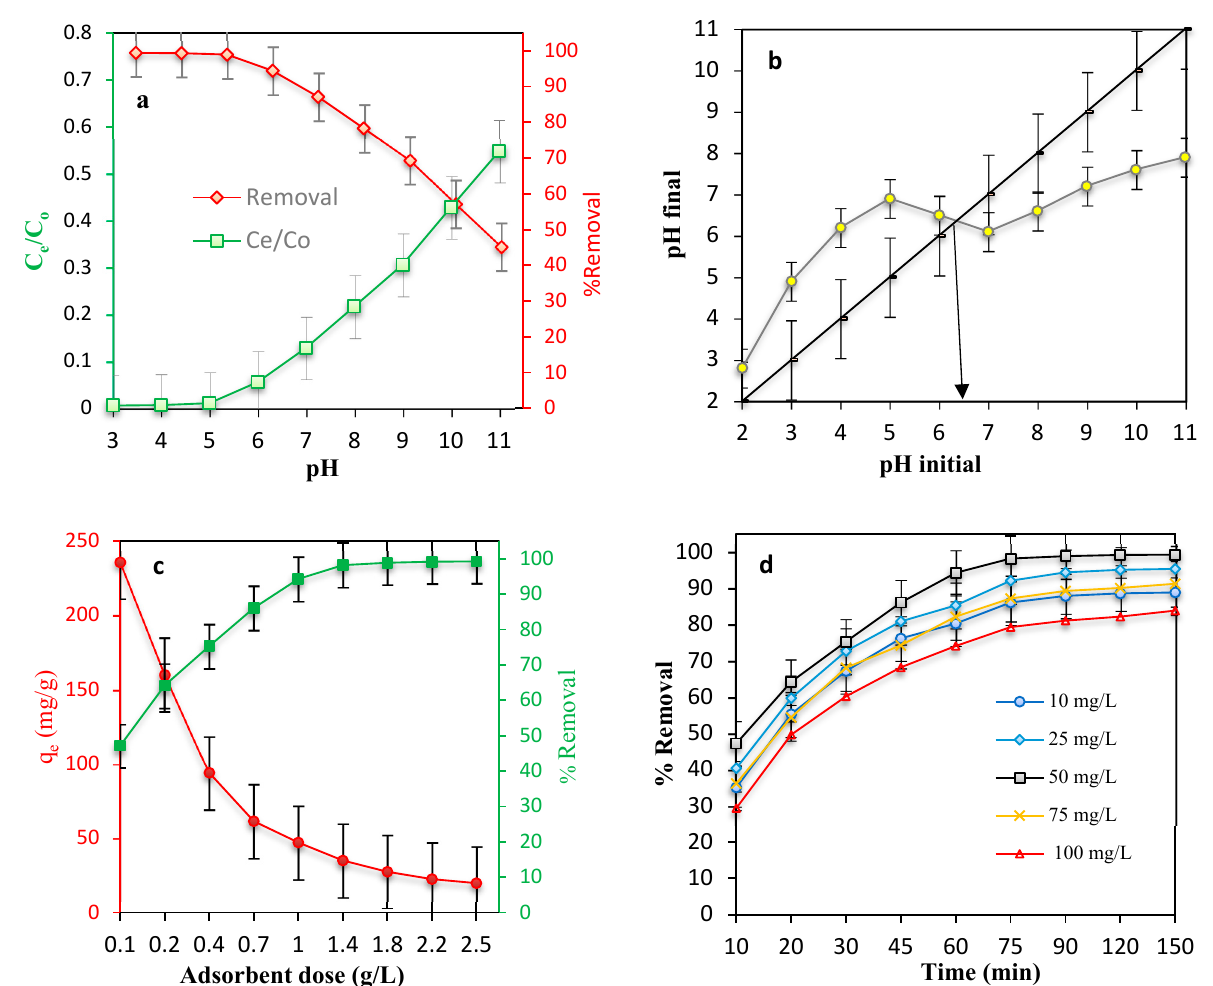
Figure 4. Results of the experiments of the effect study: solution pH ( a ), determination of the pH PZC value ( b ), effect of MWCNTs/CoFe 2 O 4 dose ( c ), initial LFX concentration and mixing time ( d ).